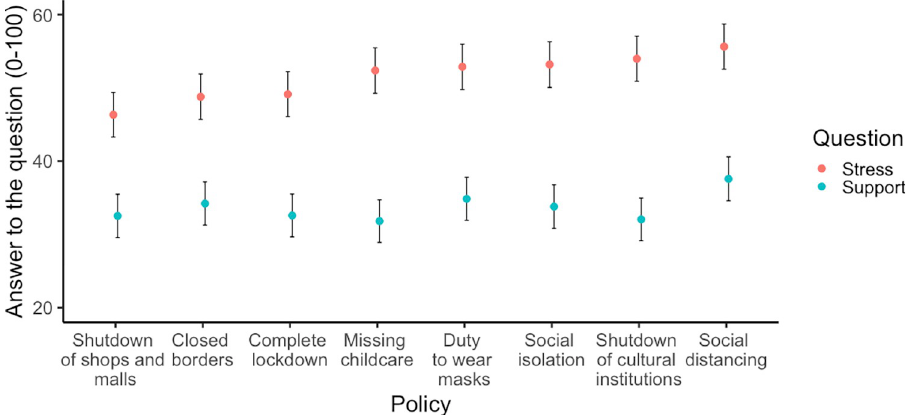
Fig 1. The amount of stress and support of different COVID-19-related policies. Error bars indicate 95% CIs. The answers to the questions about the level of stress and support for each policy were recorded on a scale between 0 and 100. A higher score indicates higher stress levels (in red) or stronger support for restrictive policies (in blue). The policies are ordered by the level of stress.